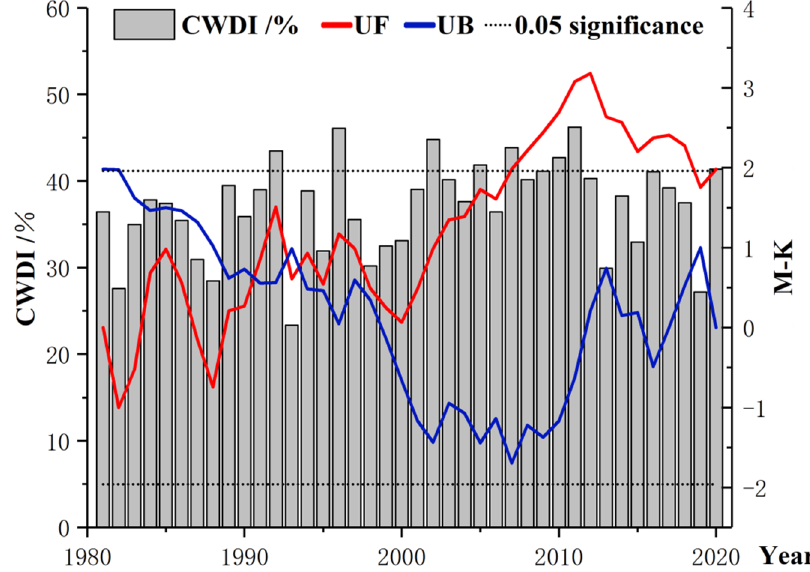
Figure 6. Variation of CWDI in the growing season and using the M − K test.